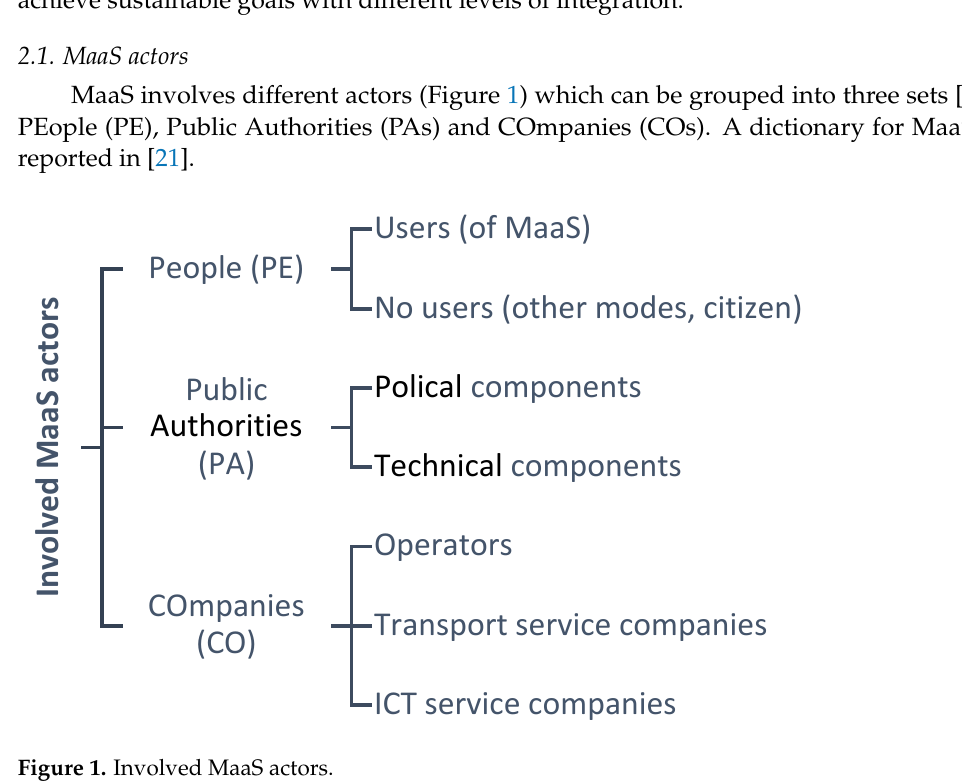
Figure 1. Involved MaaS actors.